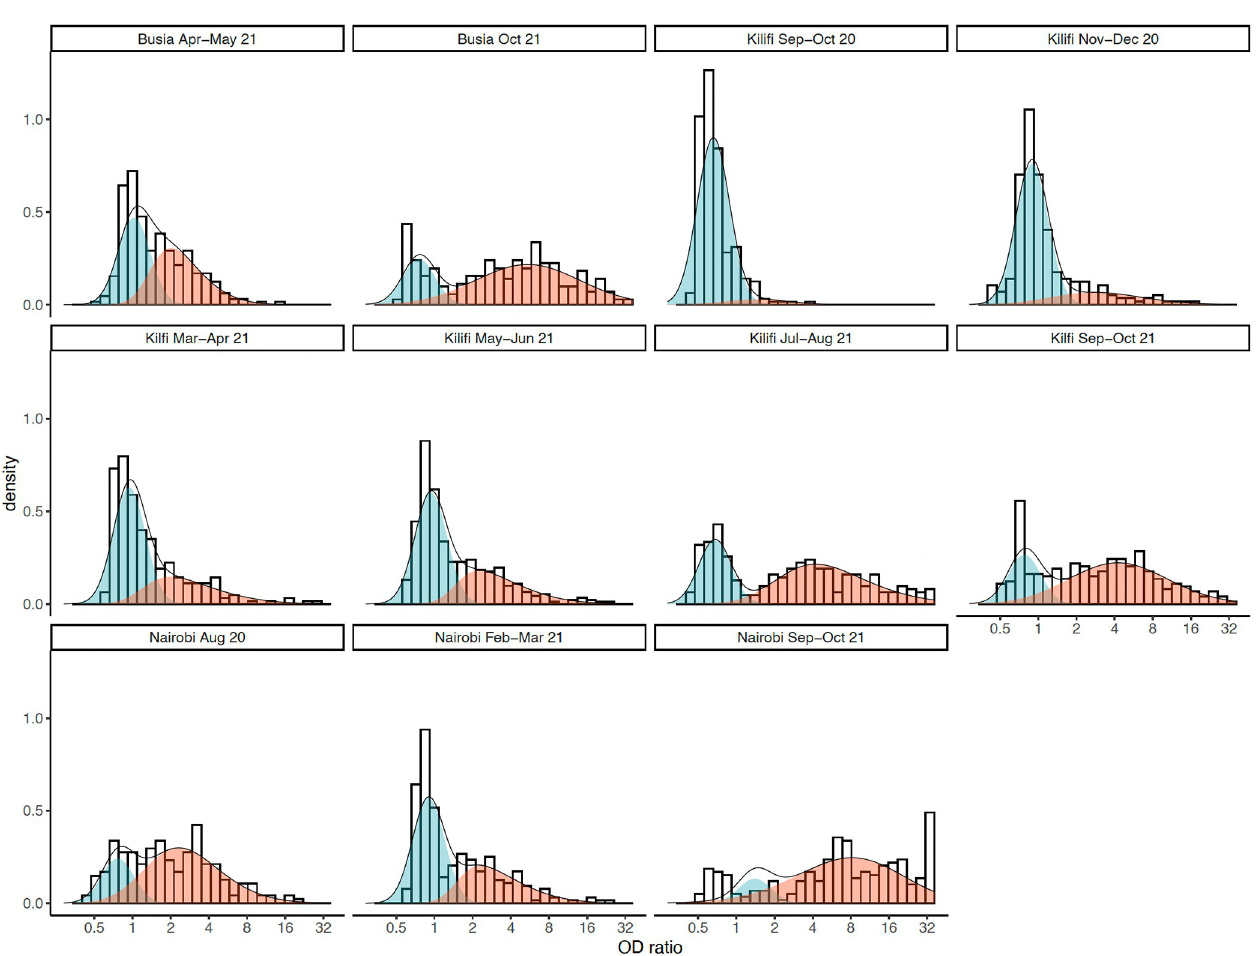
Fig 1. Mixture distributions fitted to anti-spike IgG antibody data collected in Kilifi (KCH), Busia and Nairobi (KNH). The red distribution represents predicted responses in individuals previously infected with SARS-CoV-2 and the blue distribution represents predicted responses in previously uninfected